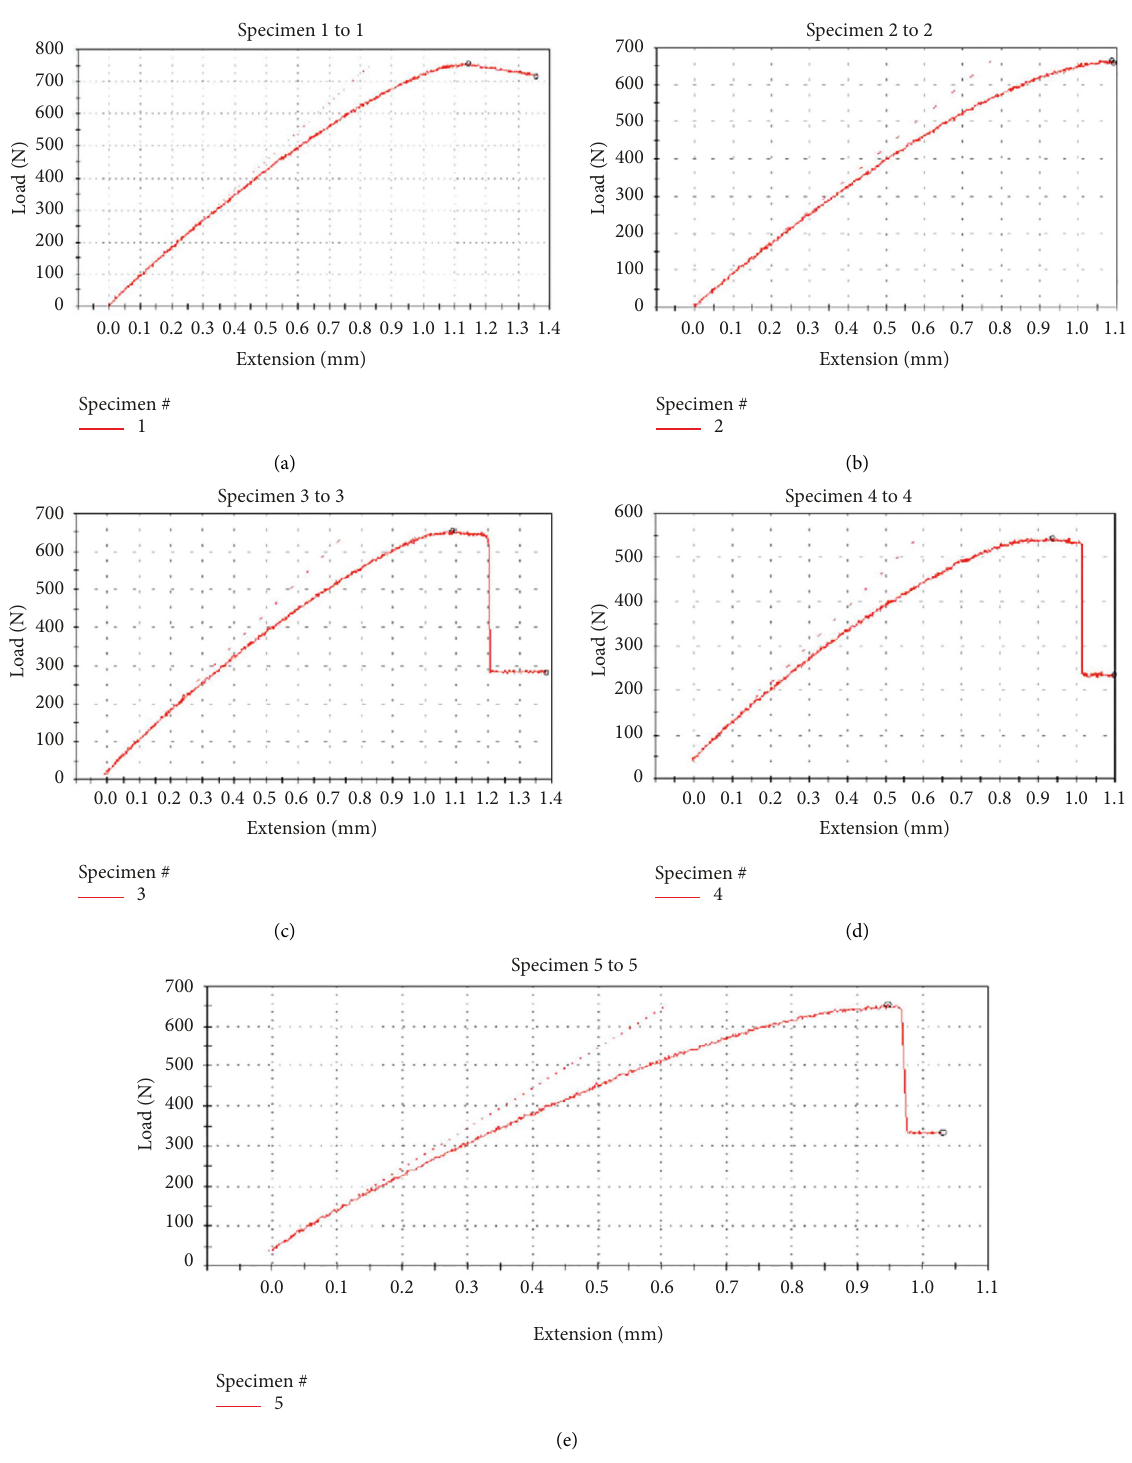
Figure 5: Load vs. extension curve of the